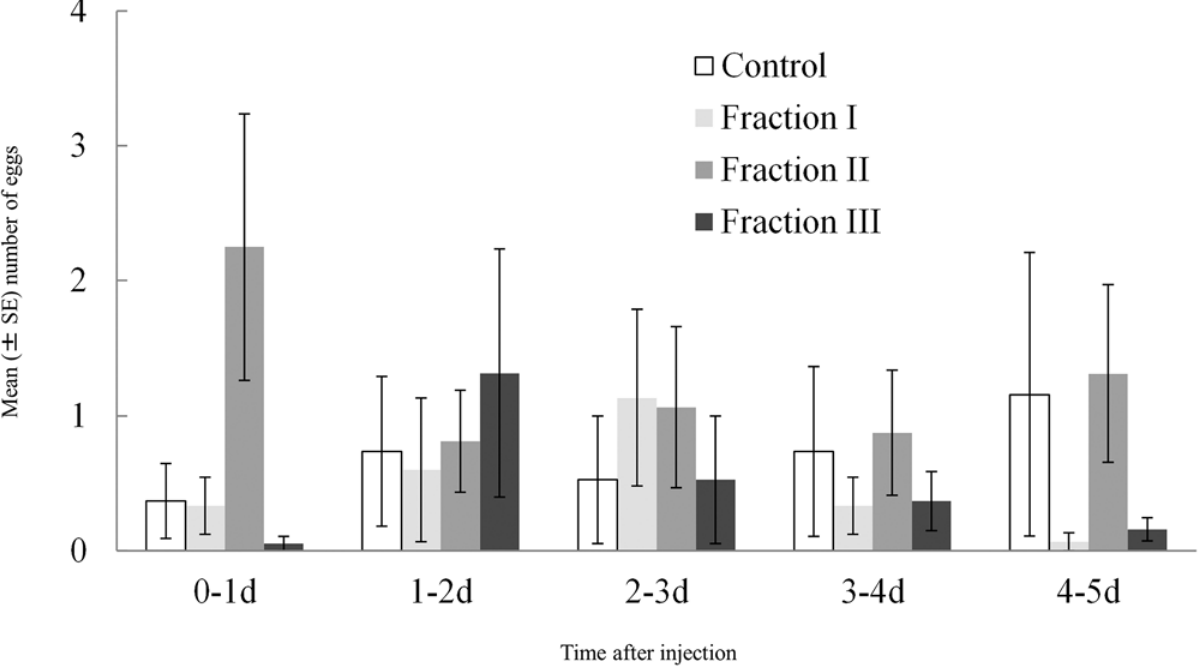
Fig 5. The number of eggs laid by virgin females (N = 16 – 19 per treatment group) provided with beans as oviposition substrate and injected with an aqueous solution of accessory gland extract (Fraction I [molecular weight < 25 kDa], Fraction II [MW, 25 – 50 kDa], or Fraction III [MW > 50 kDa]), or Milli-Q water only (control), here shown separately for each of five consecutive 24-h